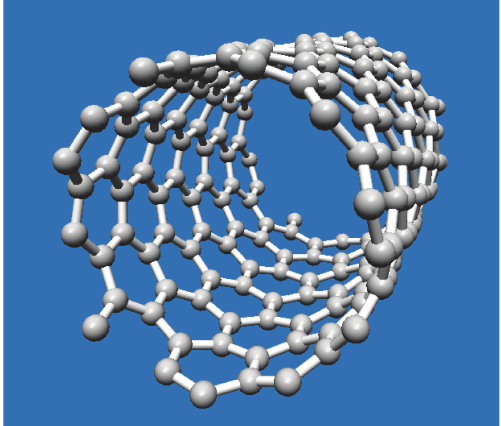
Figure 5: Schematic representation of a Single wall carbon nanotube (SWNT).